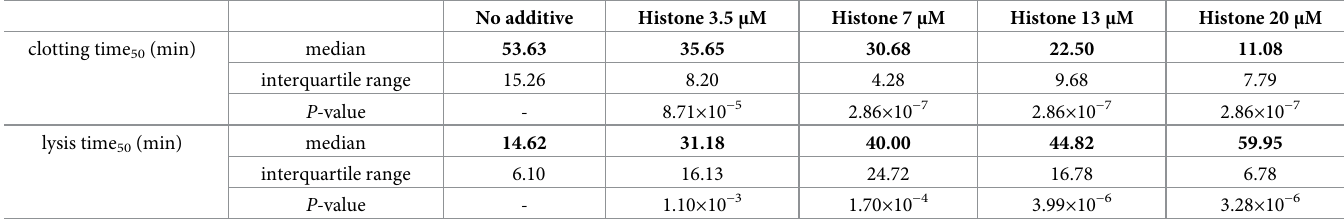
Table 3. Effects of histone on fibrin formation and